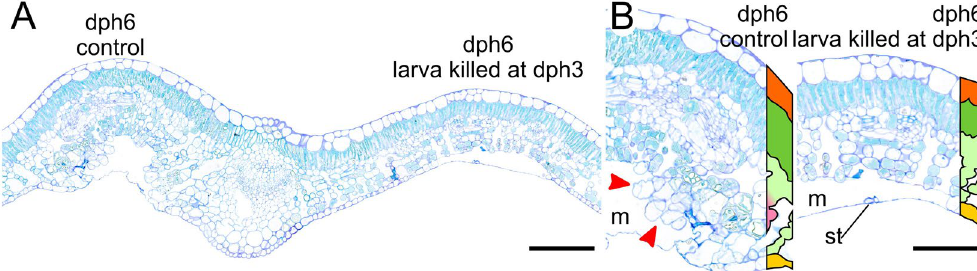
Figure 2. Histological sections of Caloptilia cecidophora gall after larva abortion. Cross sections of Glochidion obovatum leaves attacked by C . cecidophora were made at 6 day post-hatching (dph6) after killing the larva at dph3. Legend, m: mine, st: stomata, for remaining see Fig. 1. Scale: 500 µ m for ( A ), 100 µ m for ( B ). Staining: Toluidine Blue